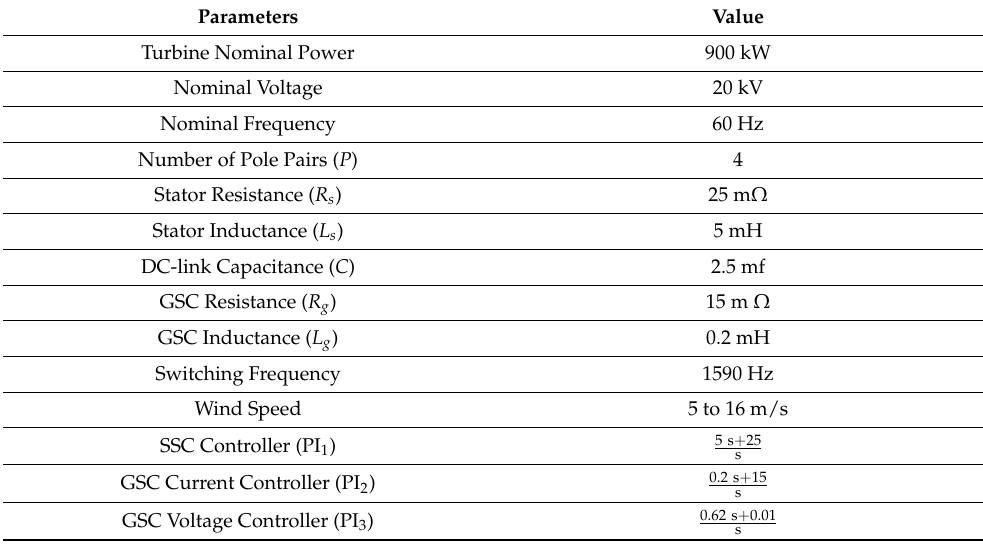
Table 6. Parameters of the proposed